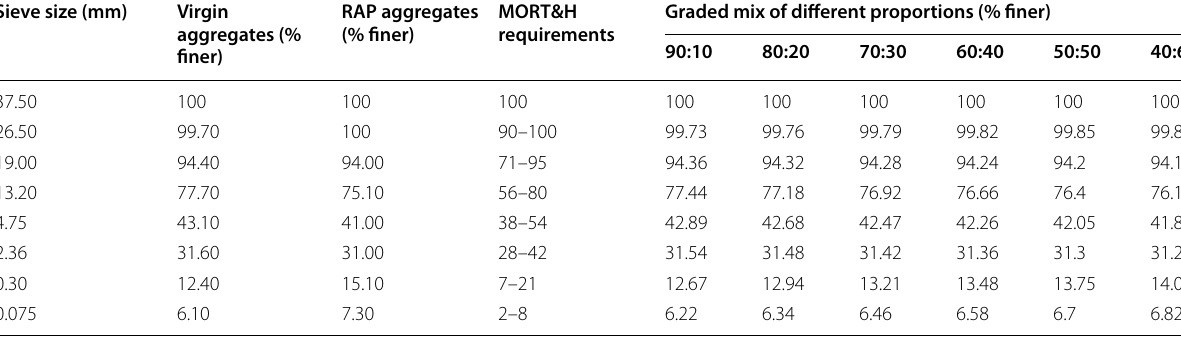
Table 3 Gradation of DBM (Grade II) mix with different percentages of RAP aggregate Sieve size (mm) Virgin RAP aggregates aggregates (% (% finer) finer)